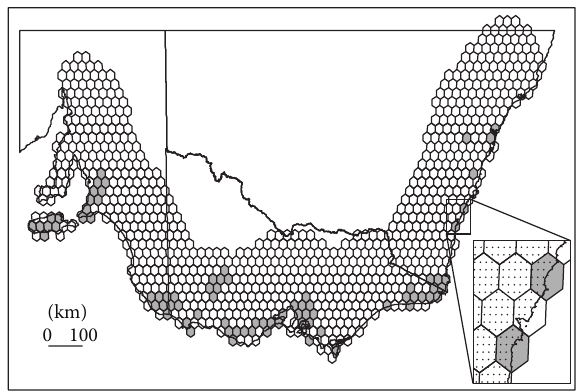
Figure 3: Hexagonal sampling scheme used to characterize climate throughout the distribution of Isoodon obesulus obesulus in south- eastern Australia. Gray hexagons have locality records of I. o. obesulus associated with them whereas hollow hexagons have no records and were, therefore, treated as regions where the subspecies is absent. BIOCLIM values were calculated based on overlaid points illustrated in the